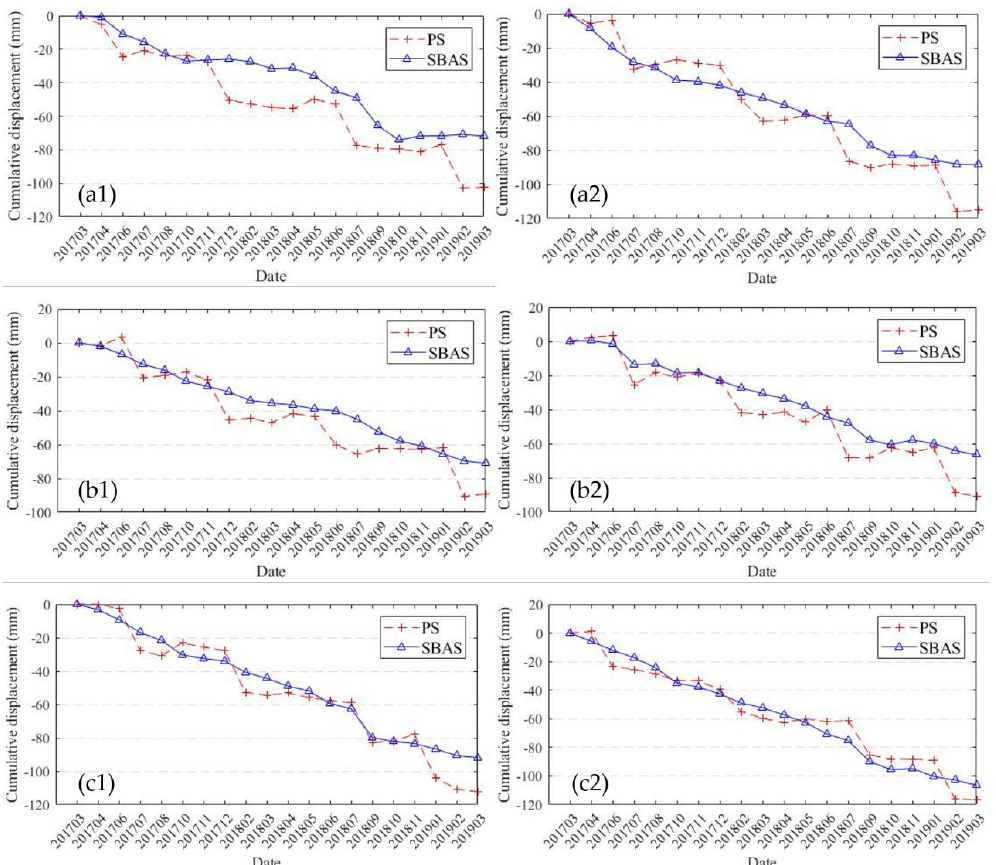
Figure 10. Time series of the surface subsidence from the two MT-InSAR methods at selected points. Points ( a1 ) and ( a2 ) fall on two plants in the emerging industrial parks. Point ( b1 ) is located on a new high-rise building, and point ( b2 ) on Jinba Railway. Points ( c1 ) and ( c2 ) are located in the old residential area in the suburbs.